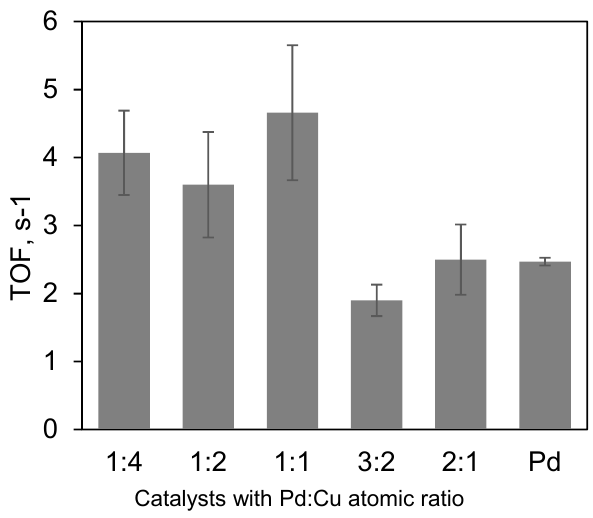
Figure 2. Turn ‐ over frequency of Pd and Pd ‐ Cu catalysts. Figure 2. Turn-over frequency of Pd and Pd-Cu catalysts.